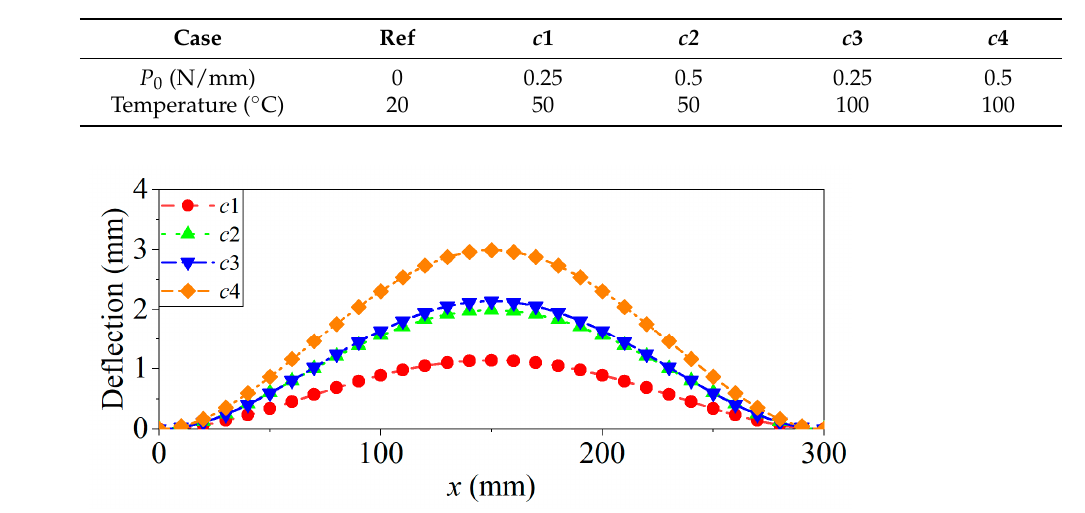
Table 8. Di ff erent cases set of combined loads. Table 8. Different cases set of combined loads.